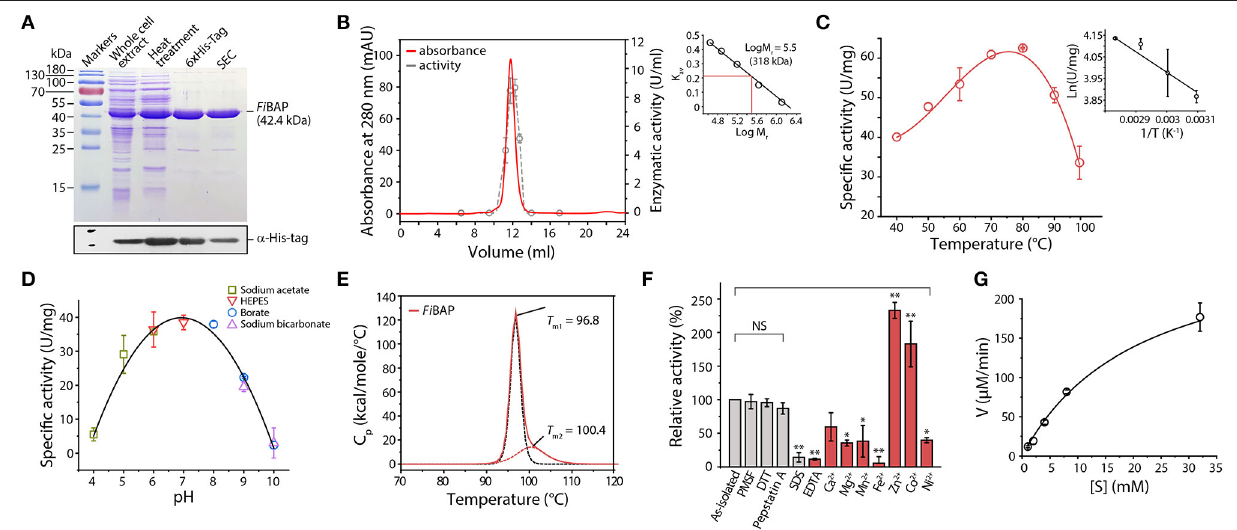
FIGURE 2 | Biochemical properties of Fi BAP. (A) Purification of recombinant Fi BAP analyzed by 12% SDS-PAGE. (B) Size-exclusion chromatography of Fi BAP using a Superdex 200 pg 10/300 column and the enzyme activity of the eluents. The column was calibrated with blue dextran (2,000 kDa), thyroglobulin (669 kDa), ferritin (440 kDa), aldolase (158 kDa), conalbumin (75 kDa), and ovalbumin (44 kDa) as standards ( Supplementary Figure 2 ). The calibration curve shows Log M r and K av values for each standard protein. (C) Temperature dependence of Fi BAP activity. (D) Dependence of Fi BAP activity on pH. (E) DSC analysis of Fi BAP. (F) Effects of divalent metal ions and inhibitors on Fi BAP activity. Group differences were assessed using one-way analysis of variance (ANOVA), followed by Tukey HSD test (* p < 0.05 and ** p < 0.01 vs. as-isolated). (G) Kinetic analysis of Fi BAP. The kinetic parameters for purified Fi BAP were estimated by steady-state kinetics analysis using β -DL as